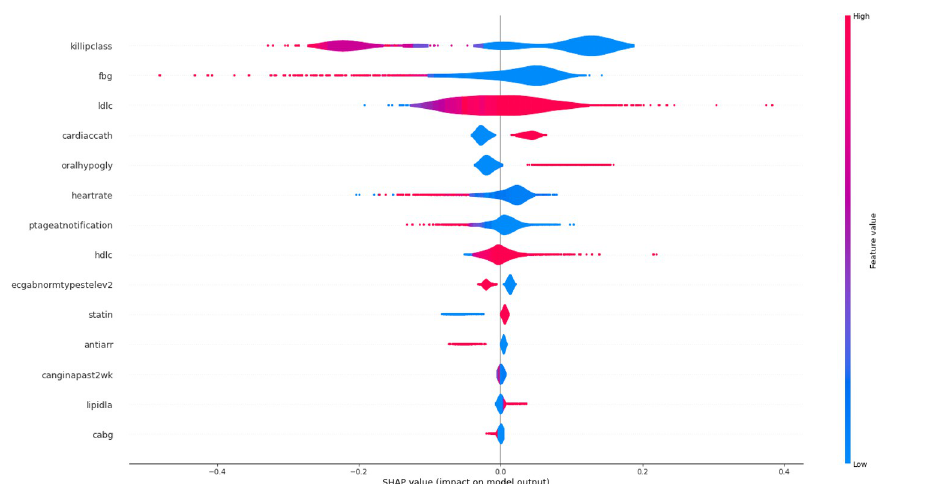
Fig 4. SHAP summary plot of SVM